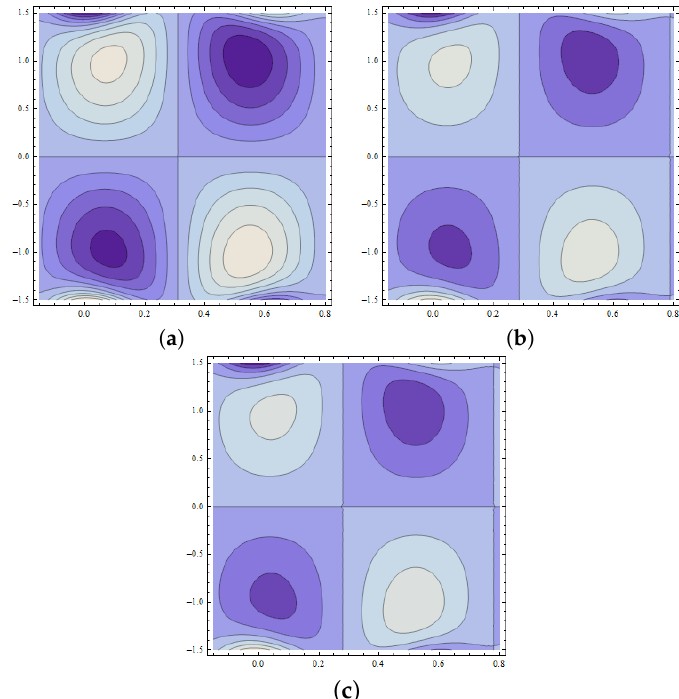
Figure 20. Pattern of streamlines when (cid:101) = 0.1, t = 0.1, m = 0.04, m 1 = 2, E 1 = 0.1, E 2 = 0.2, n = 0.4 and We = 0.4 with ( a ) E 3 = 0.5, ( b ) E 3 = 0.8, ( c ) E 3 = 0.9.